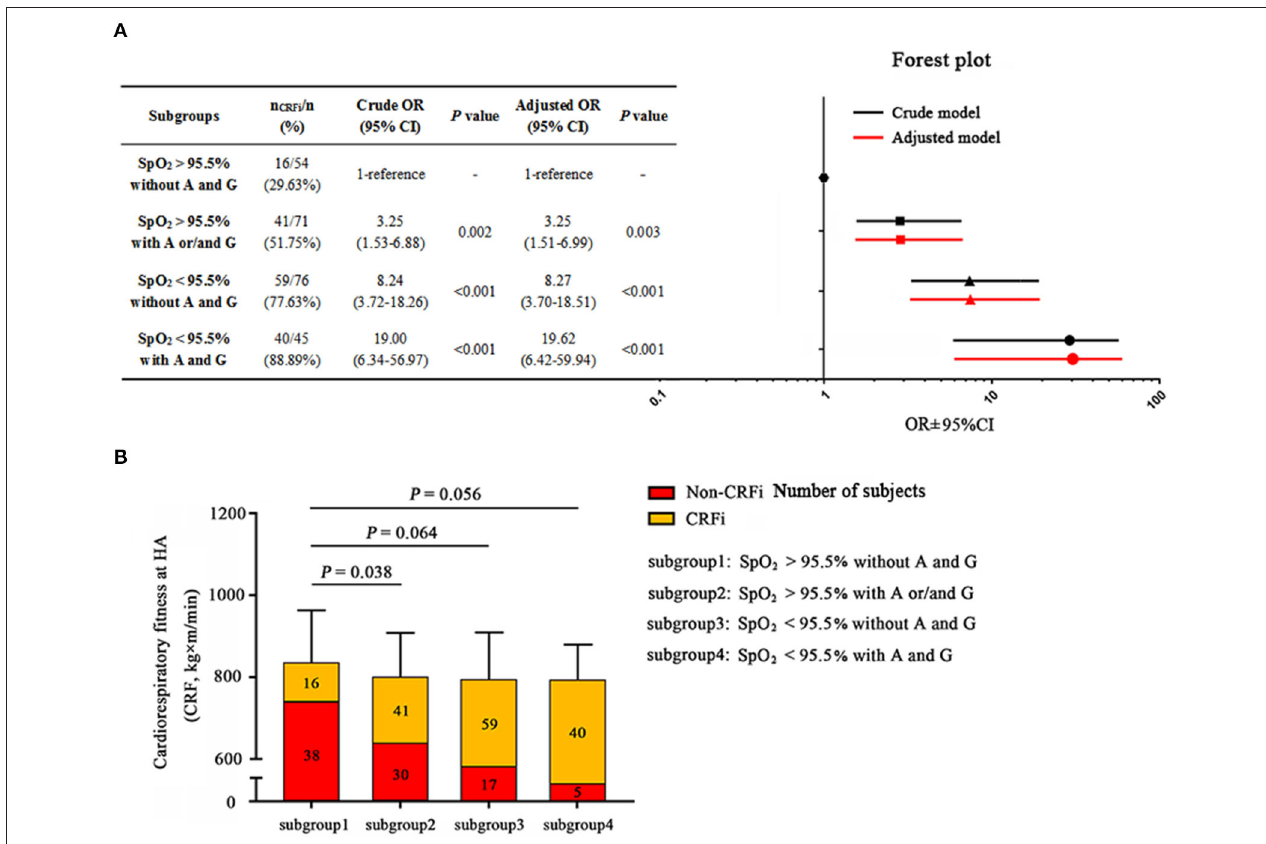
FIGURE 5 | The Combination model prediction of high-altitude cardiorespiratory fitness. (A) Subjects are divided into subgroups: subgroup 1, post-submaximal exercise SpO 2 at SL > 95.5% and carrying neither the EPAS1 rs13419896-A nor EGLN1 rs508618-G; subgroup 2, post-submaximal exercise SpO 2 at SL > 95.5% and carrying EPAS1 rs13419896-A and/or EGLN1 rs508618-G; subgroup 3, post-submaximal exercise SpO 2 at SL < 95.5% and not carrying EPAS1 rs13419896-A or EGLN1 rs508618-G; subgroup 4, post-submaximal exercise SpO 2 at SL < 95.5% and carrying EPAS1 rs13419896-A and EGLN1 rs508618-G. Post-submaximal exercise SpO 2 at SL < 95.5% combined with carrying EPAS1 rs13419896-A and EGLN1 rs508618-G was the most effective prediction model with OR = 19.62 and 95% CI: 6.42–59.94, p < 0.001. The forest plot shows the OR and 95% CI of subgroups compared to the WT in the adjusted model. The x-axis of the forest plot was numbered by log10 in GraphPad prism 7.0. (B) The distribution of subjects and cardiorespiratory fitness in the four subgroups. The cardiorespiratory fitness of subgroup 1 to subgroup 4 was 834.59 ± 131.08, 800.27 ± 109.89, 793.62 ± 117.34, and 793.24 ± 88.67 kg × m/min, respectively. Subgroups 2 ( p = 0.038), 3 ( p = 0.064), and 4 ( p = 0.056) had lower cardiorespiratory fitness compared to subgroup 1. The yellow and red squares represent the proportion of CRFi and non-CRFi in each subgroup, respectively. The number of subjects in each subgroup is shown on the histogram. SpO 2 , oxygen saturation; SL, sea level; HA, high altitude;